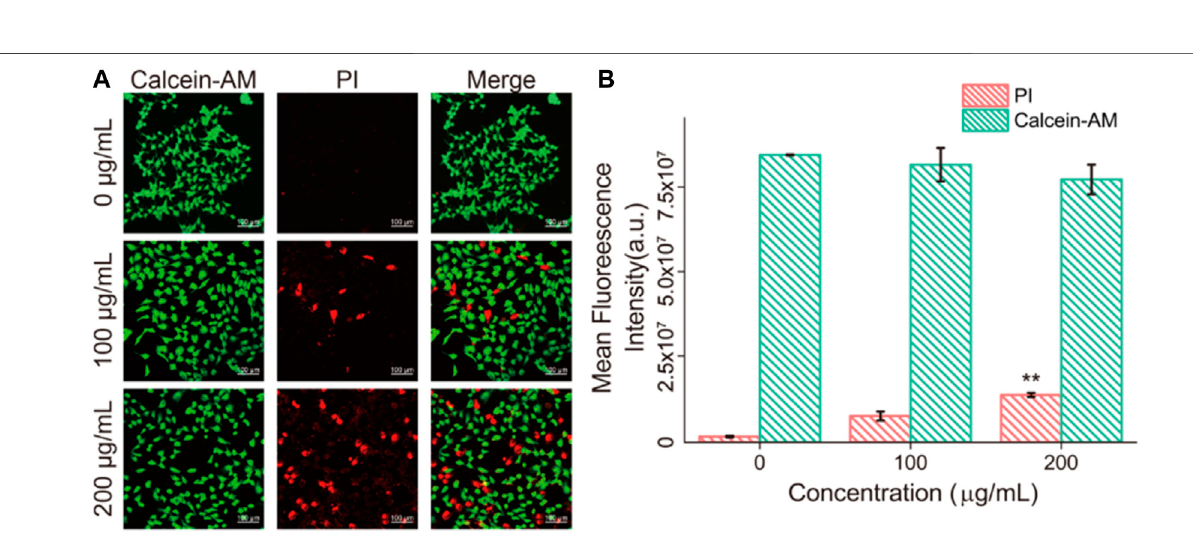
Frontiers in Chemistry |